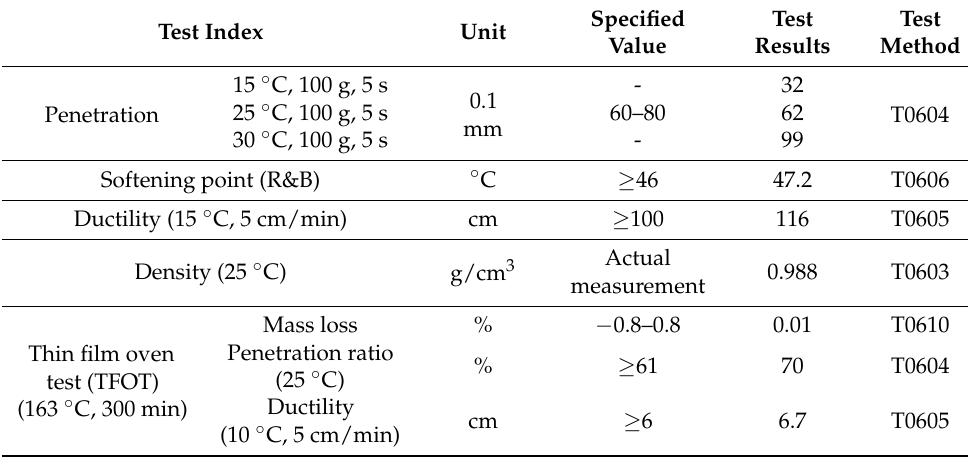
Table 1. Technical indexes of 70 # base asphalt.